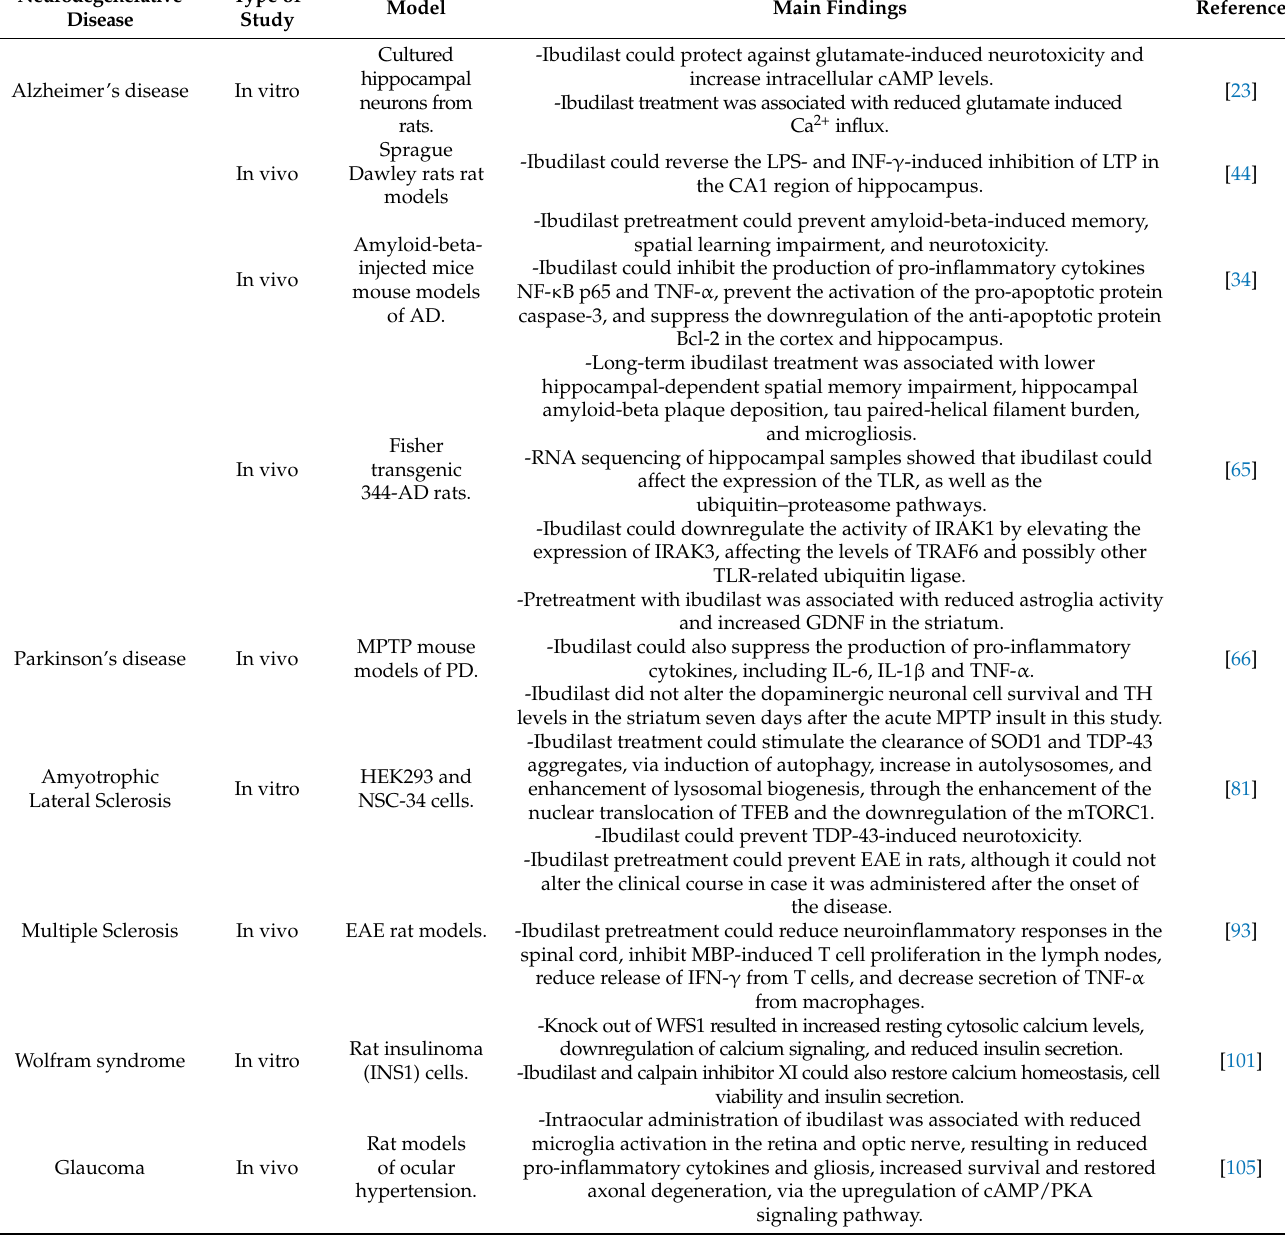
Table 3. Preclinical evidence on the role of ibudilast in neurodegenerative diseases. Neurodegenerative